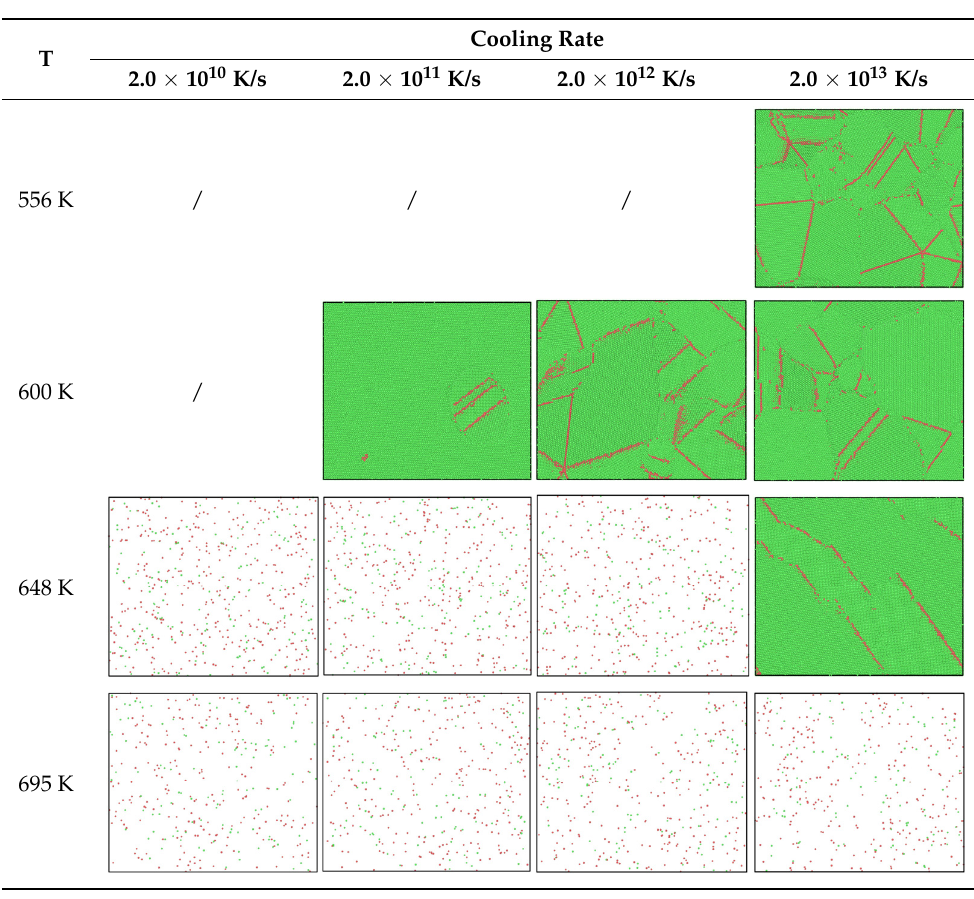
Table 2. Cooling rates and temperature of isothermal solidification used in the simulation.